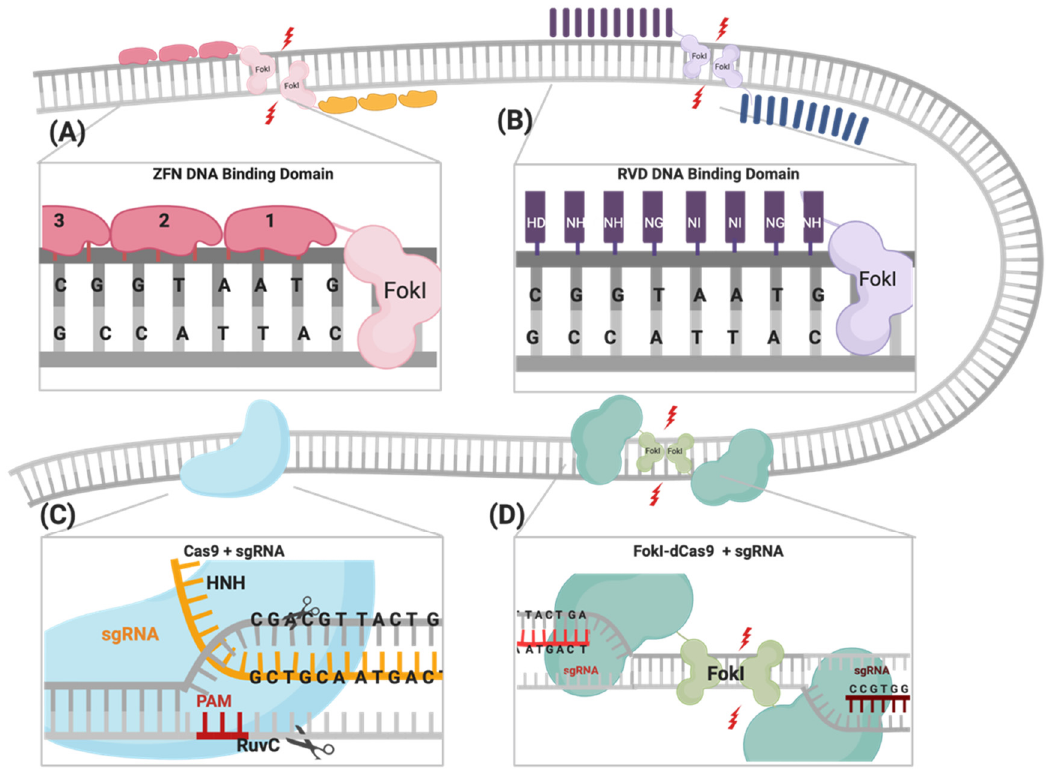
Figure 1. Illustrations of different genome engineering tools. ( A ) Zinc fingers nucleases (ZFNs) bind to the target sequence through 3-4 zinc finger proteins, and ( B ) transcription activator-like effector nucleases (TALENs) through repeat variable diresidues (RVDs), both of which inducing double-stranded breaks (DSBs) through heterodimerization and the catalytic activity of the fused FokI. ( C ) CRISPR–Cas9 binds to the DNA target through PAM sequences and the complementary sgRNA site, where the catalytic activity is mediated through HNH and RuvC domains. ( D ) FokI–dCas9 (inactive “dead” form of Cas9) binds to the target site through two sgRNAs that are positioned in a PAM-out orientation, and the catalytic activity is mediated through the dimerization of fused FokI endonuclease.